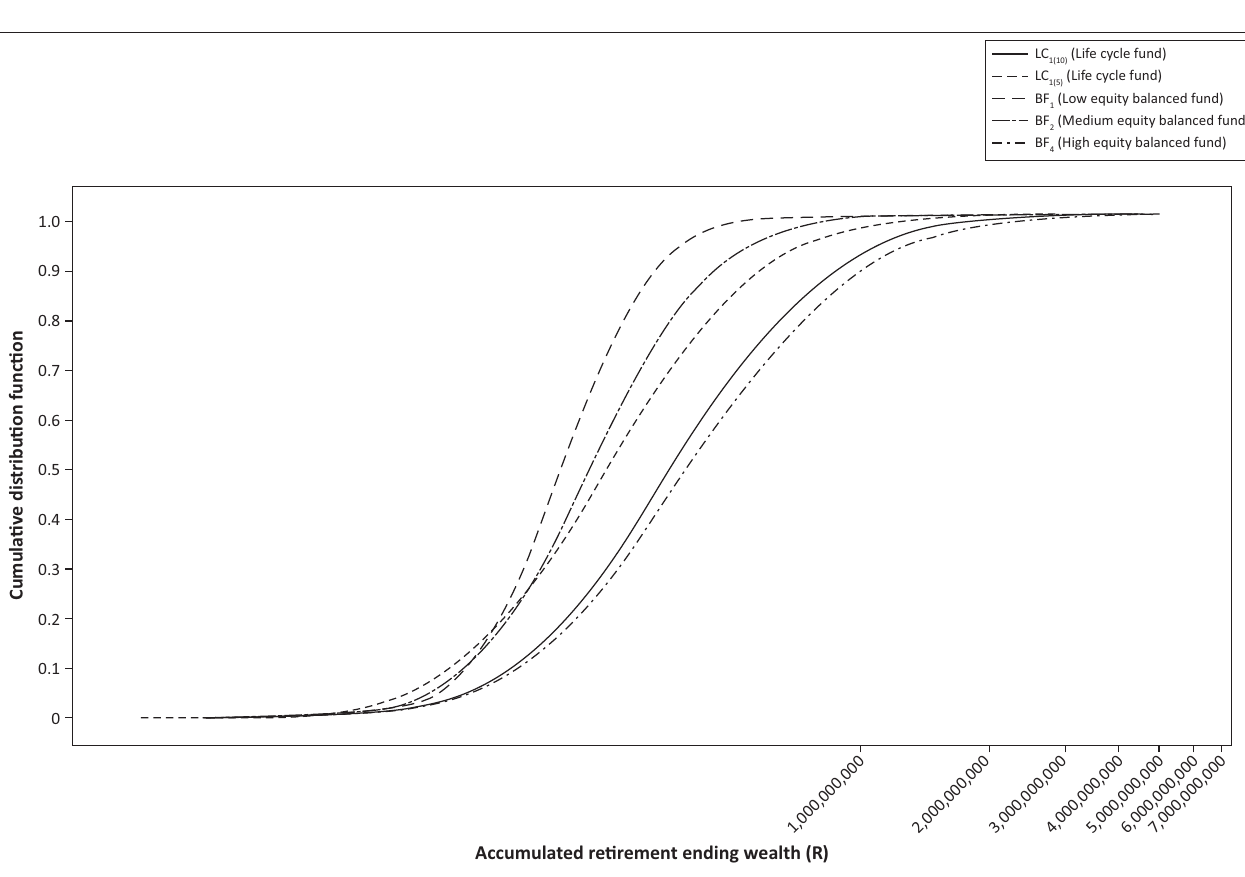
and LC against models BF 1(10) 1(5)